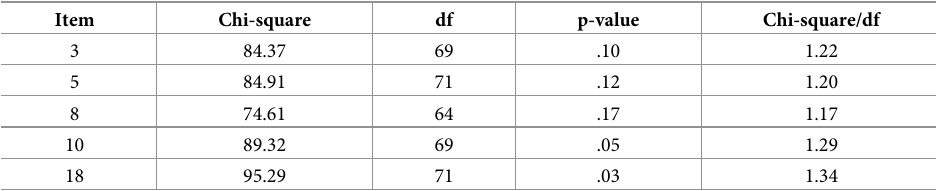
Table 2. Goodness-of-fit Chi-Square tests for the five-item scale in Study 1.